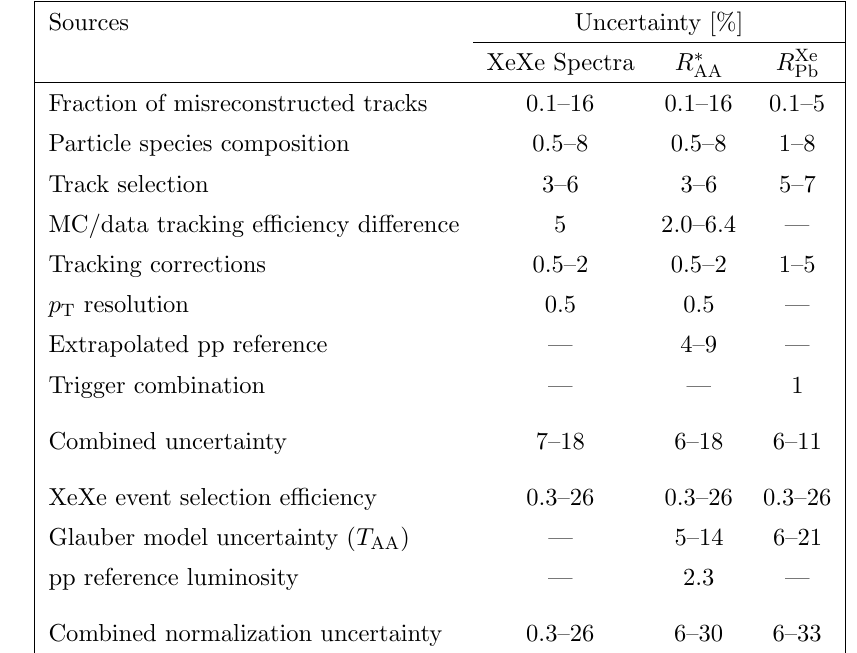
Figure 2 . The ratio of charged-particle spectra in pp collisions at di(cid:11)erent MC generators. A (cid:12)t to the pythia ratio is shown by the red line.